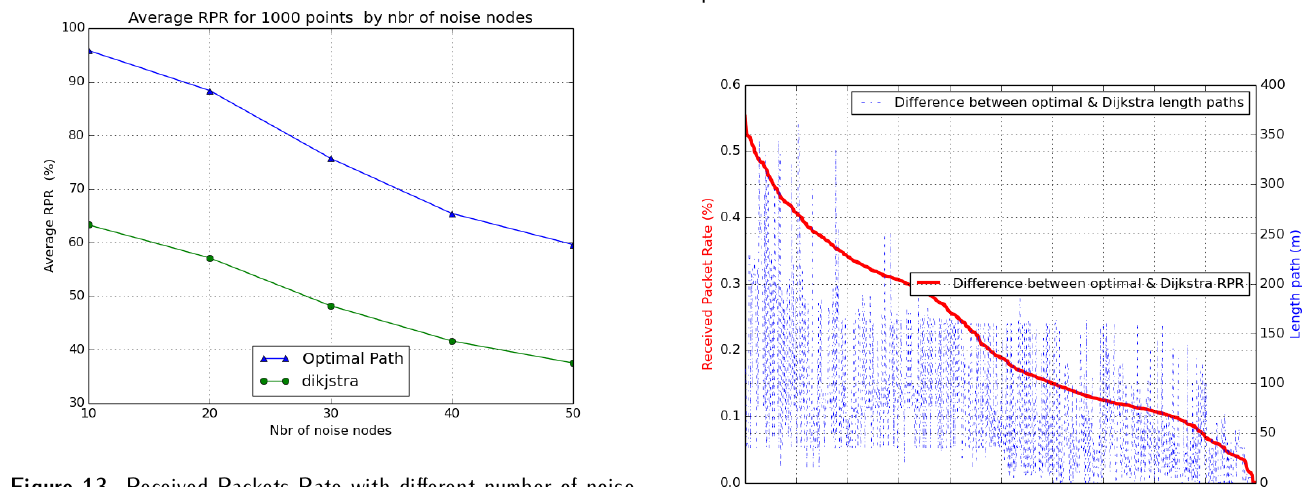
Figure 14. Difference between optimal and Dijkstra path length, nbr paths = 1000